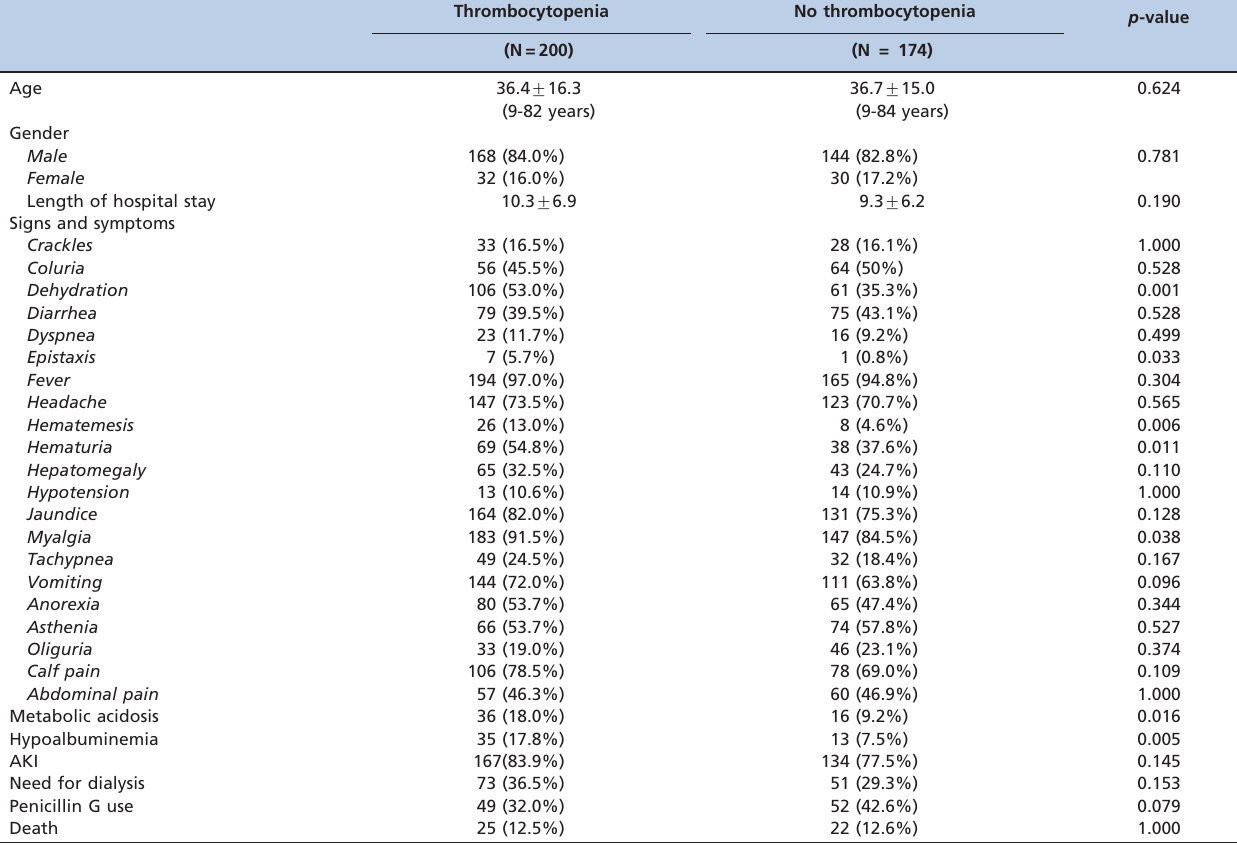
Table 1 - Comparison of the demographics and clinical manifestations of leptospirosis patients with and without thrombocytopenia at